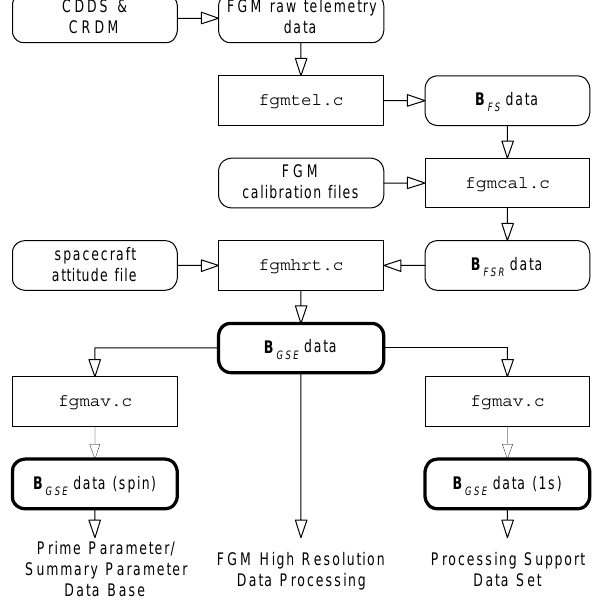
Fig. 8. Simplified flow diagram of the FGM data processing soft-